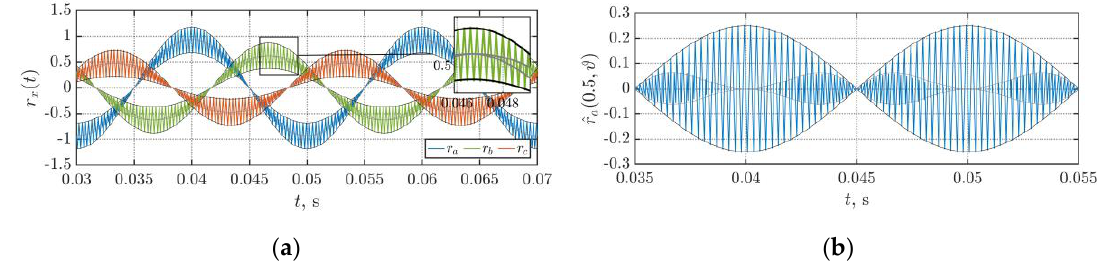
Figure 6. Primary (black) and secondary (gray) envelopes in case of SPWM at m = 0.5 and f sw = 3.6 kHz: ( a ) Normalized phase currents; ( b ) Normalized phase current ripple.